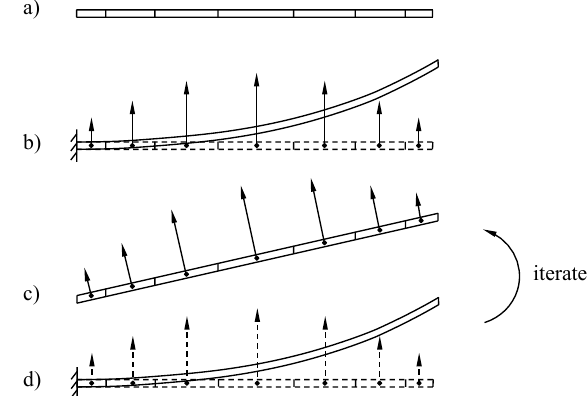
Figure 17. Fluid–Structure Interaction (FSI) procedure: ( a ) Initial geometry for AVL; ( b ) deflection of the wing based on the initial forces from AVL; ( c ) deflected geometry for AVL with linear variation of the deflection along the span; ( d ) deflection of the wing based on the updated forces from AVL. For the intended FSI simulation, the geometrical and structural data of the wing are given in Table 5. The airfoil used to construct the wing is the DAE11, and the wall thickness of the spar t spar is set to 1 mm. Recall that the outer diameters of the spar are fixed for the given wing geometry. Further, the flight velocity is set to 12